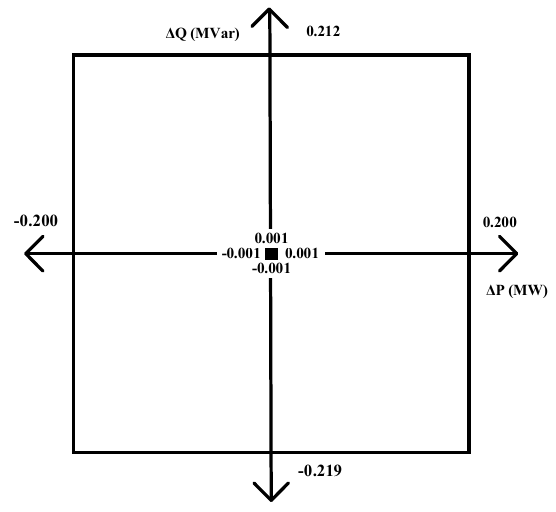
Figure 12. NDZ plot of the proposed strategy.